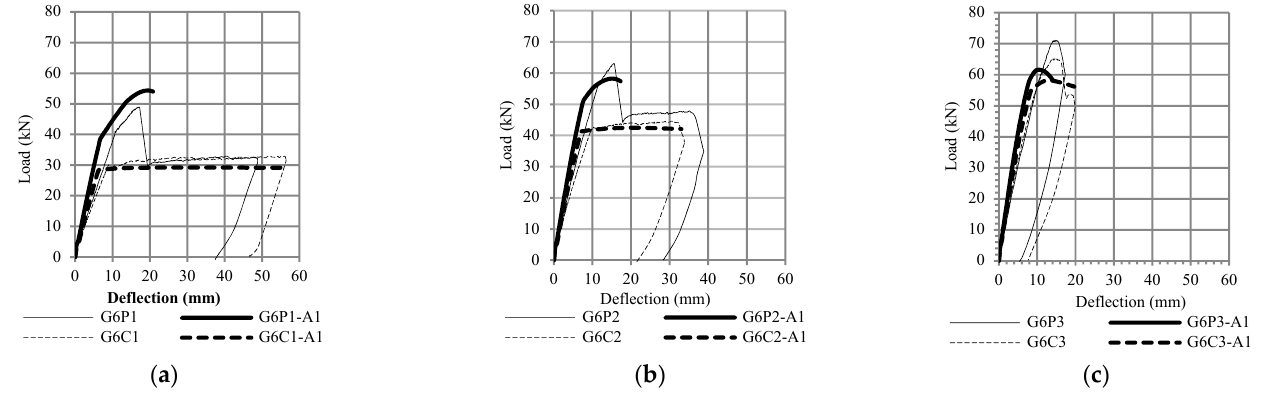
Figure 11. Comparison between test results and the fiber element method (RCCSA) ( a ) reinforcement ratio 1%, ( b ) reinforcement ratio 1.5%, and ( c ) reinforcement ratio 2.5%.